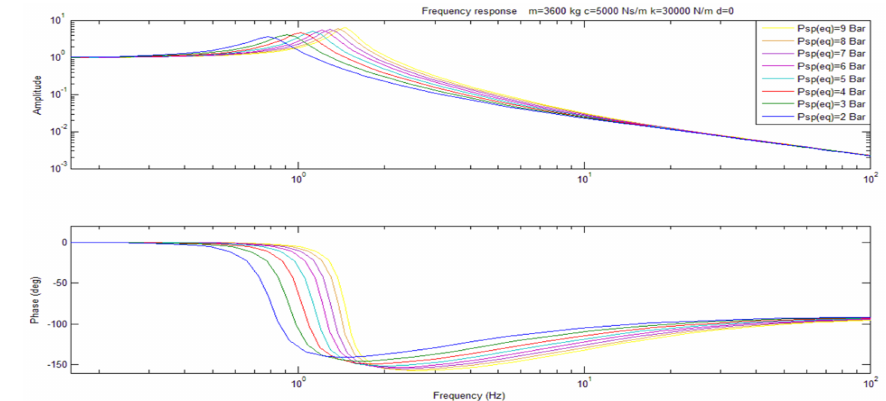
Figure 5 – Transfer function of vertical displacement for different values of static pressure Slika 6 – Prenosna funkcija vertikalnog pomeranja za razli č ite vrednosti stati č kog pritiska Рис . 6 – Передаточная функция вертикального смещения при различных коэффициентах статического